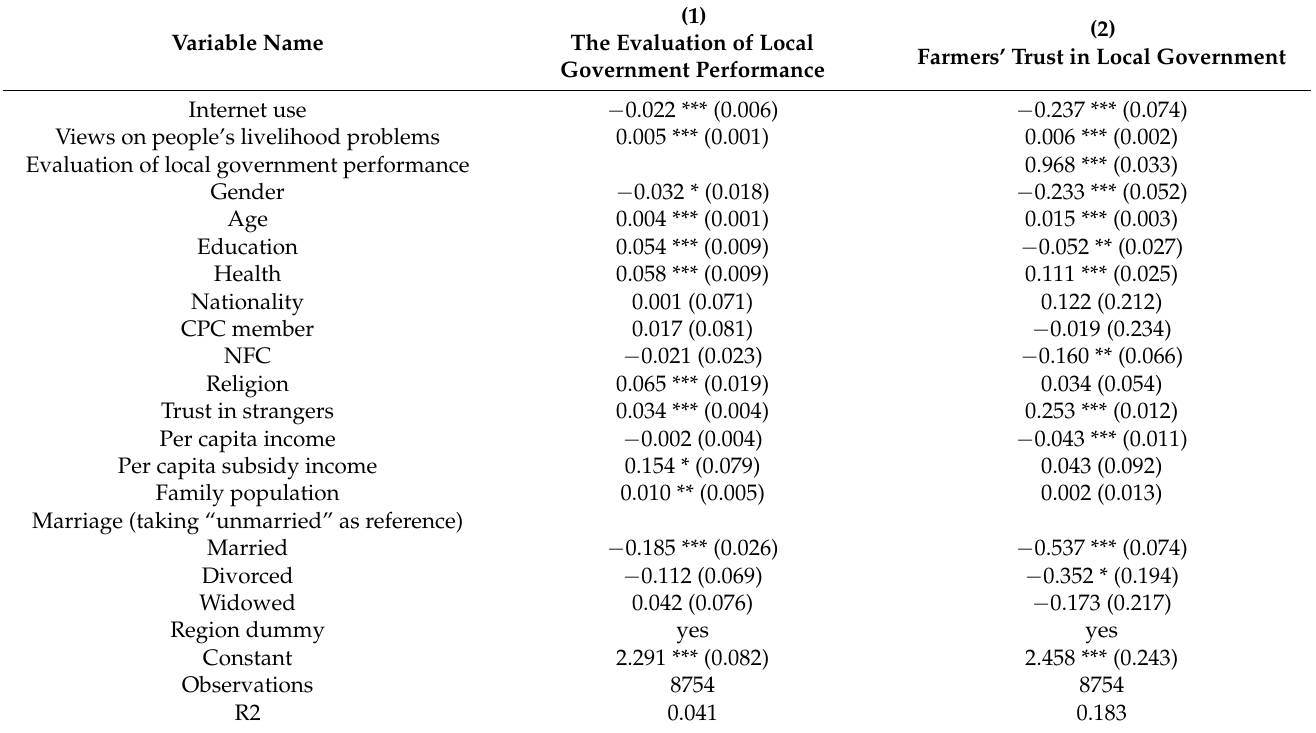
Table 7. The chain mediating effect of views on people’s livelihood problems and government performance